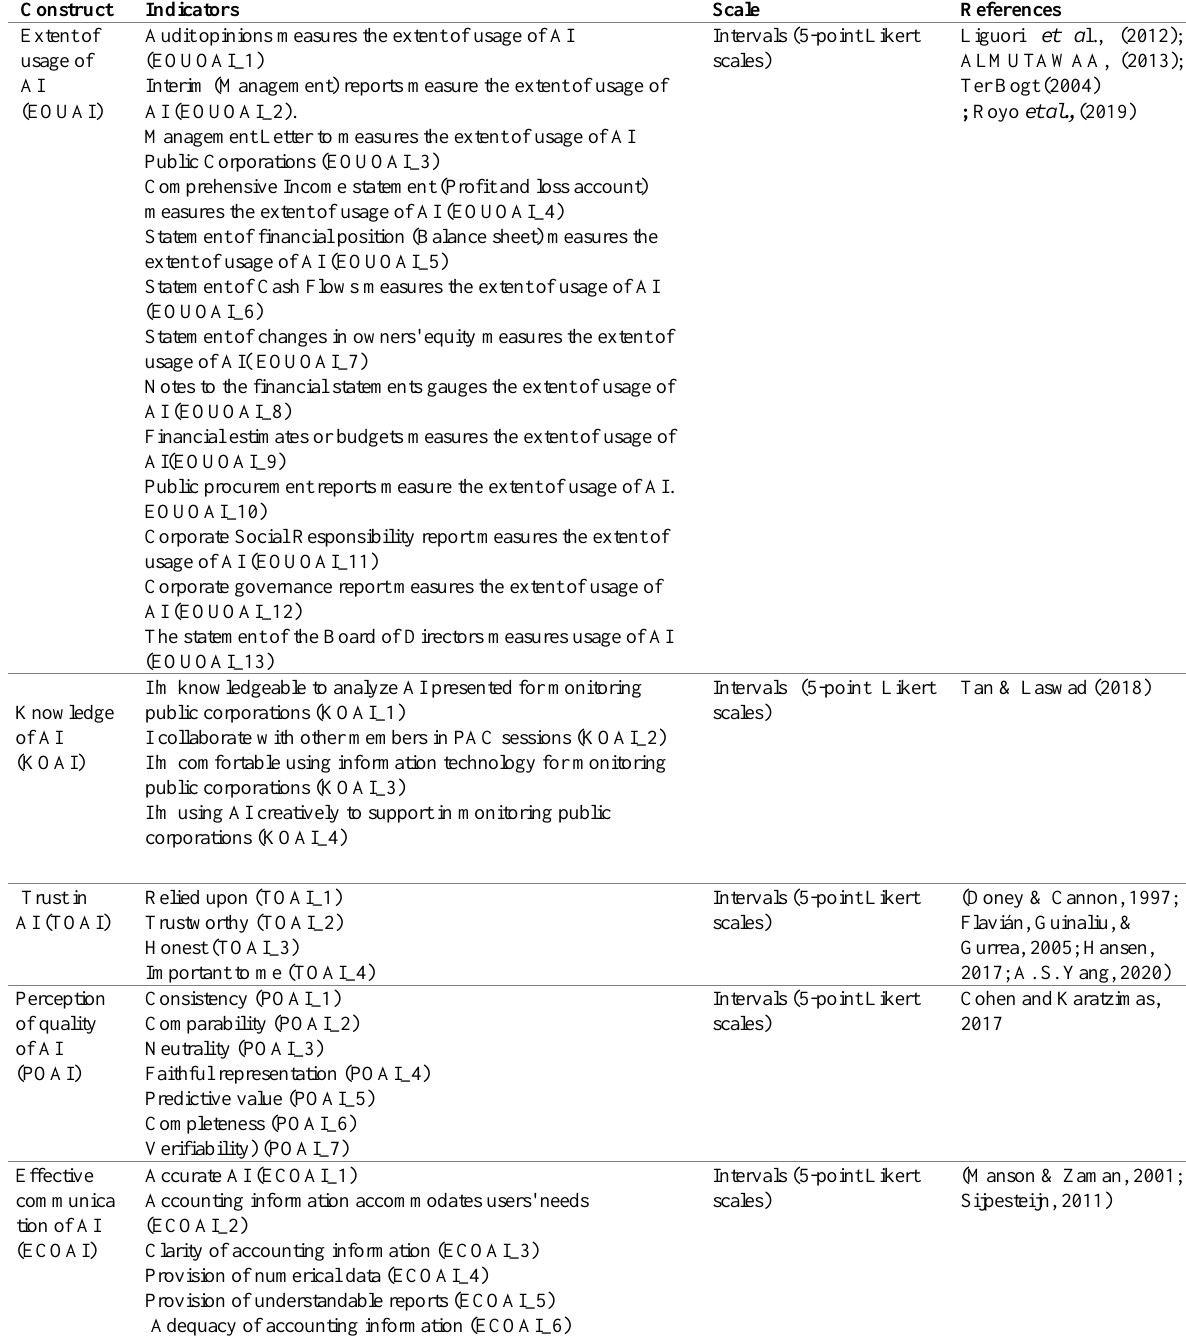
Table 1: Constructs Measurement